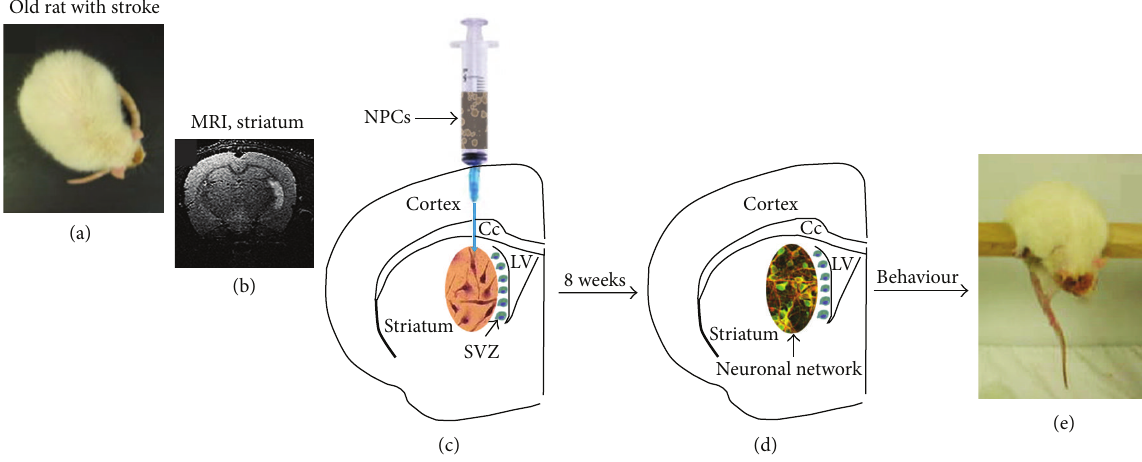
Figure1:Neuralstemtherapyofstriatalinfarcts.(a)Oldratwithstriatalinfarct.(b)DocumentationofthestriatalinfarctbyMRI.(c)Injection of NPCs into lesioned striatum. (d) Build-up of a hypothetical neuronal network weeks later. (e) Behavioural assessment of cell